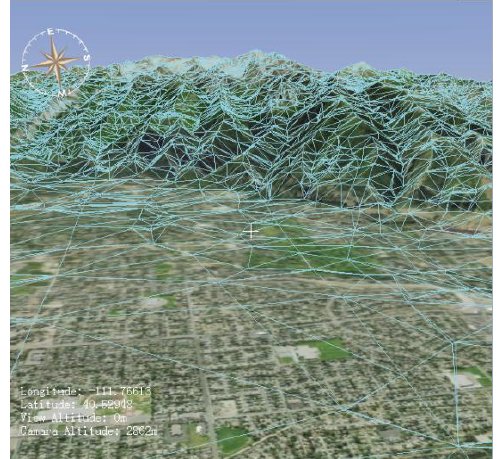
Figure 5. TIN wireframe and image data rendered together.